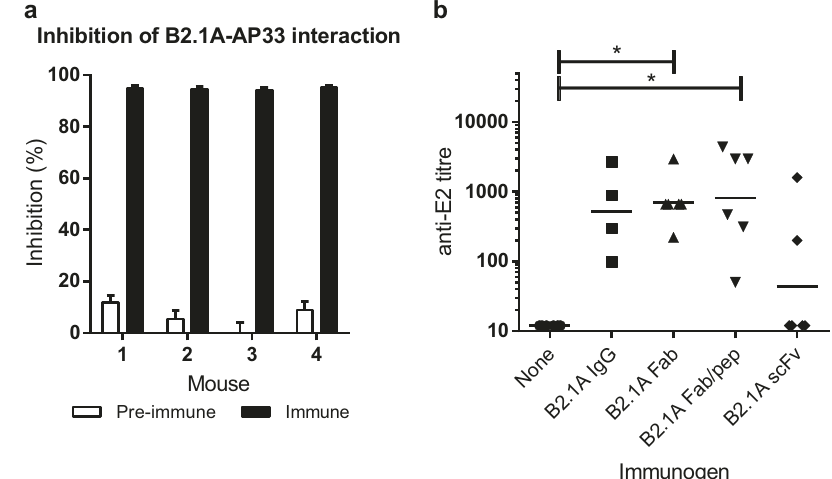
Fig. 4 B2.1 A elicits Ab1 ′ antibodies that recognize HCV E2. a Sera of mice immunized with B2.1A-KLH were tested at 1:300 dilution for blocking of biotinylated AP33 – B2.1 A interaction. Values shown are the mean and SD of three ELISAs. b Balb/c mice were given a primary immunization of B2.1 A IgG, B2.1 A Fab, or B2.1 A scFv followed by fi ve boosters of the same antigen, or a primary immunization of B2.1 A Fab followed by alternate boosters of B2.1 A Fab and E2 411 – 424 peptide. The anti-E2 titer of immune sera collected nine days after the last booster was measured by ELISA. Each symbol represents one animal and the horizontal lines indicate the geometric mean of each group; signi fi cant differences from the control group are indicated (* p <